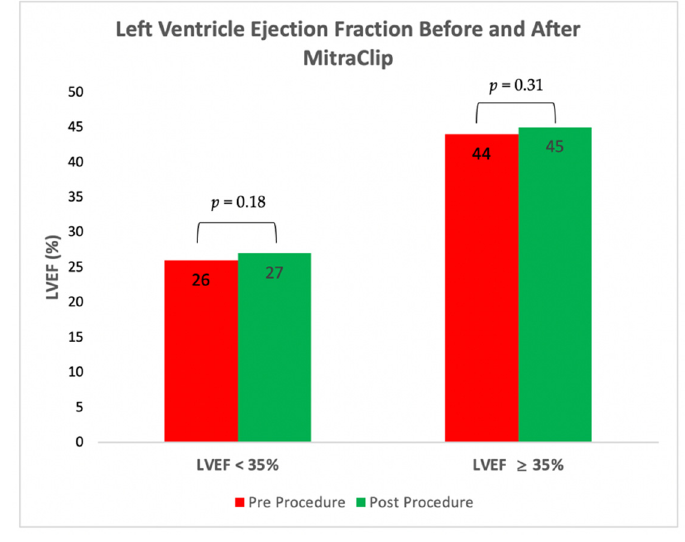
Figure 1. MR grades at presentation, discharge, 3-month and 1-year follow-up. MR was significantly reduced from presentation to discharge in both LVEF groups. MR reduction remains consistent after discharge and throughout follow-up in both groups.